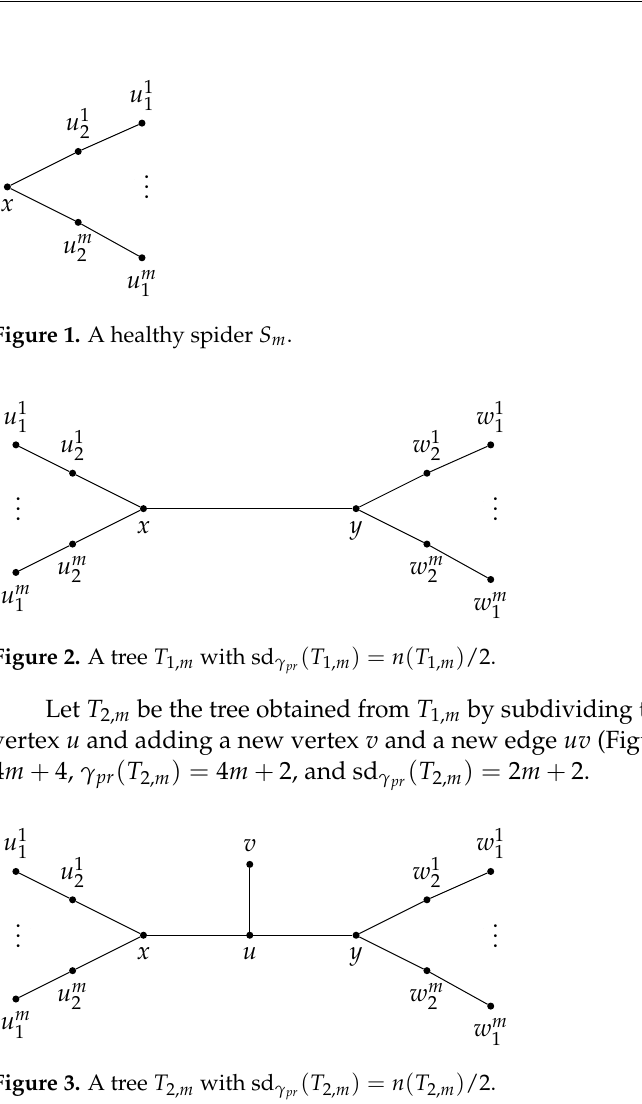
Figure 3. A tree T 2, m with sd γ